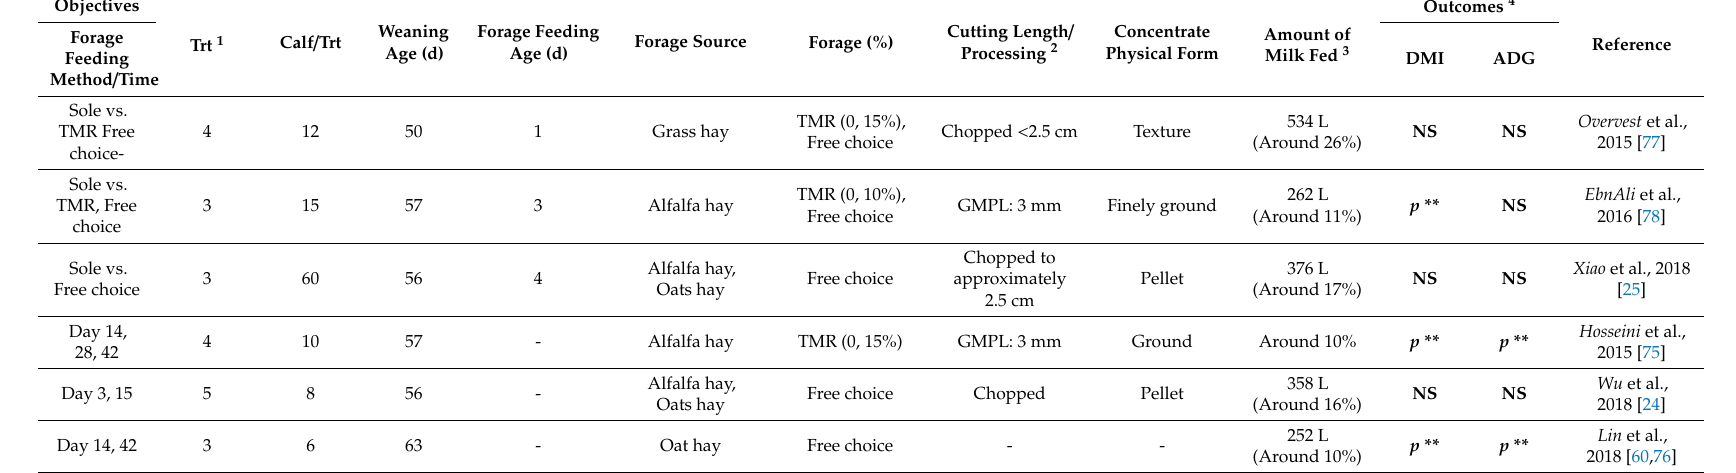
Table 4. A summary of studies di ff ering in methods and time of o ff ering forage in pre-weaned dairy